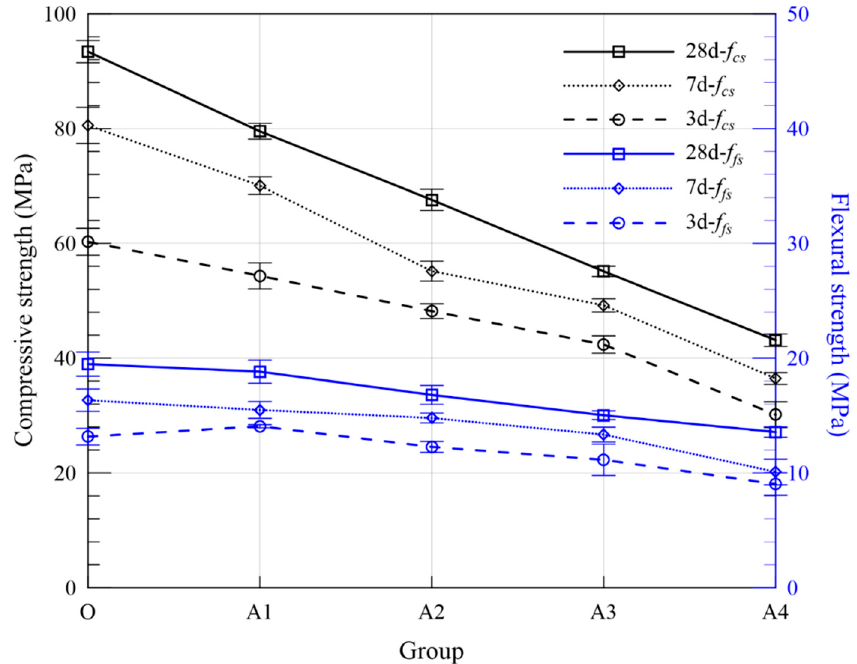
Figure 4. Effect of flexural and compressive strength of MOC-hardened pastes with FA.